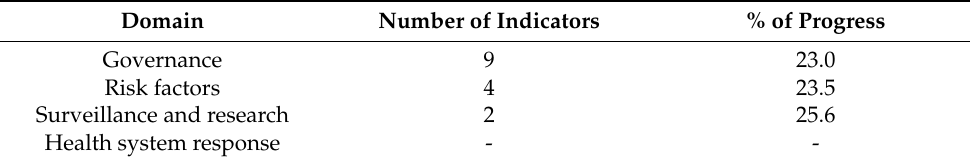
Table 2. Percentage of progress for each indicator in the three domains.